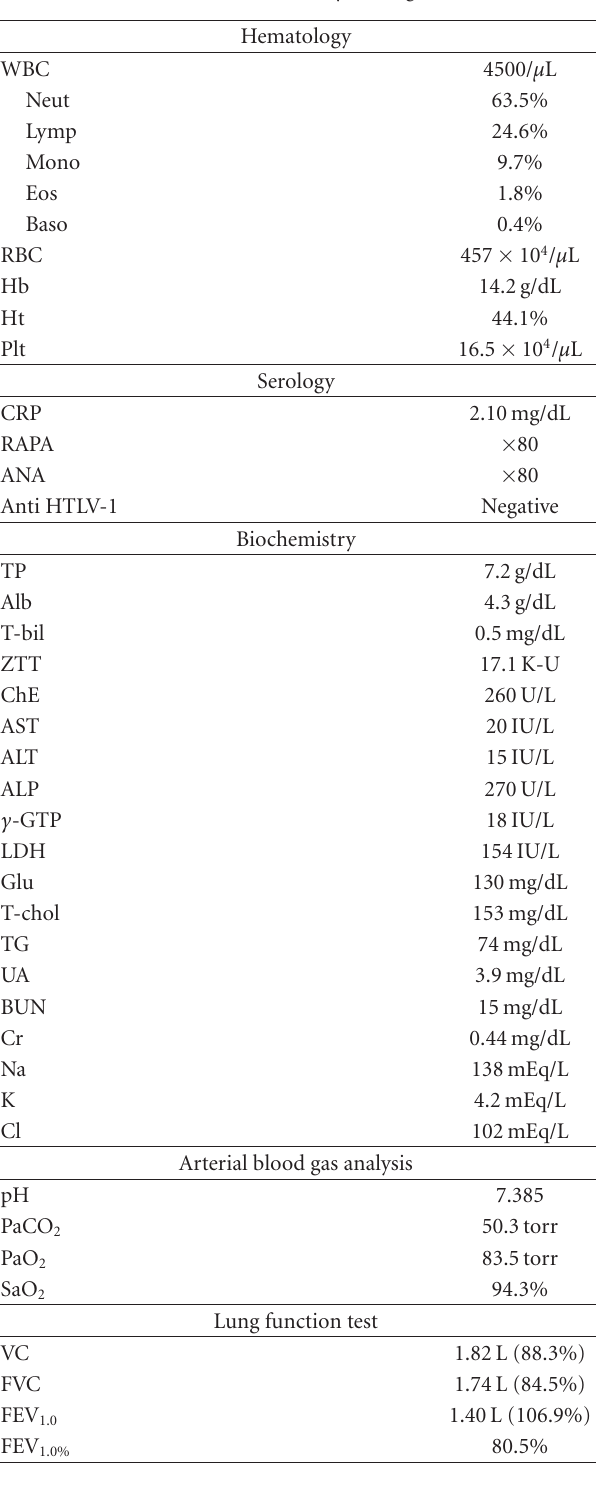
Table 1: Laboratory